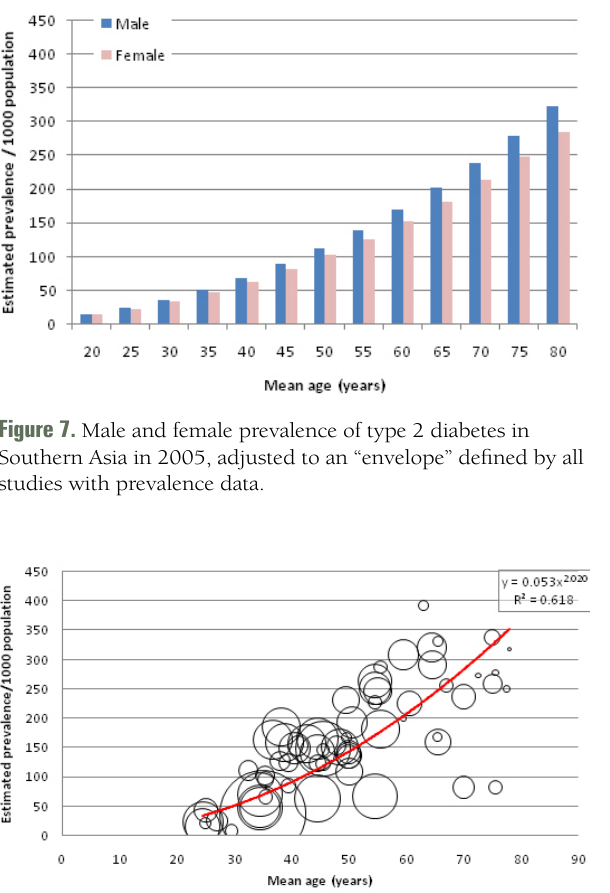
Figure 8. Crude prevalence of type 2 diabetes in Southern Asia in urban regions and its relationship with age.